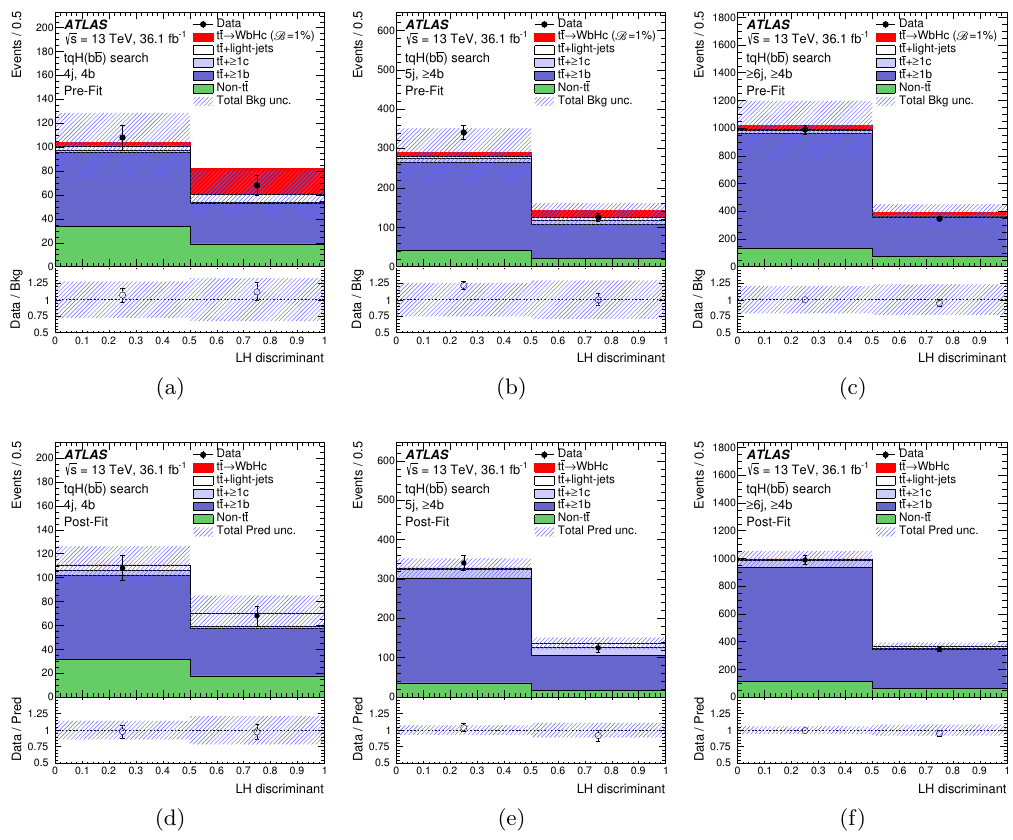
Figure 8 . tqH ( b (cid:22) b ) search: comparison between the data and prediction for the LH discriminant distribution in the regions with at least four b -tagged jets, before and after the (cid:12)t to data (\Pre-Fit" and \Post-Fit", respectively) under the signal-plus-background hypothesis. Shown are the (4j, 4b) region (a) pre-(cid:12)t and (d) post-(cid:12)t, the (5j, (cid:21) 4b) region (b) pre-(cid:12)t and (e) post-(cid:12)t, and the ( (cid:21) 6j, (cid:21) 4b) region (c) pre-(cid:12)t and (f) post-(cid:12)t. The small contributions from t (cid:22) tV , t (cid:22) tH , single-top-quark, W=Z +jets, diboson, and multijet backgrounds are combined into a single background source referred to as \Non- t (cid:22) t ". In the pre-(cid:12)t (cid:12)gures the expected t (cid:22) t ! WbHc signal (solid red) corresponding to B ( t ! Hc ) = 1% is also shown, added to the background prediction. In the post-(cid:12)t (cid:12)gures, the t (cid:22) t ! WbHc signal is normalised using the best-(cid:12)t branching ratio, B ( t ! Hc ) = ( (cid:0) 0 : 2 +2 : 3 The bottom panels display the ratios of data to either the SM background prediction before the (cid:12)t (\Bkg") or the total signal-plus-background prediction after the (cid:12)t (\Pred"). The hashed area represents the total uncertainty of the background. In the case of the pre-(cid:12)t background uncertainty, the normalisation uncertainty of the t (cid:22) t + (cid:21) 1 b background is not included.